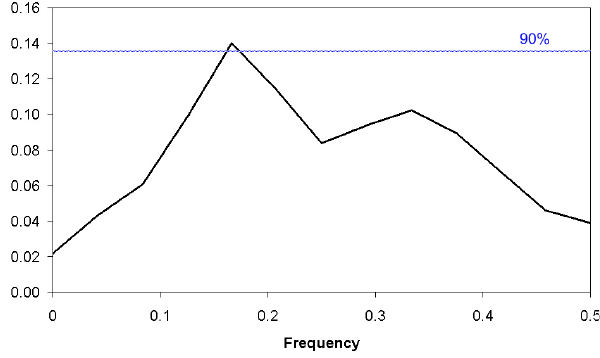
Fig. 6. Spectral analysis of the winter storms series obtained using 3.6m as wave height threshold to define a